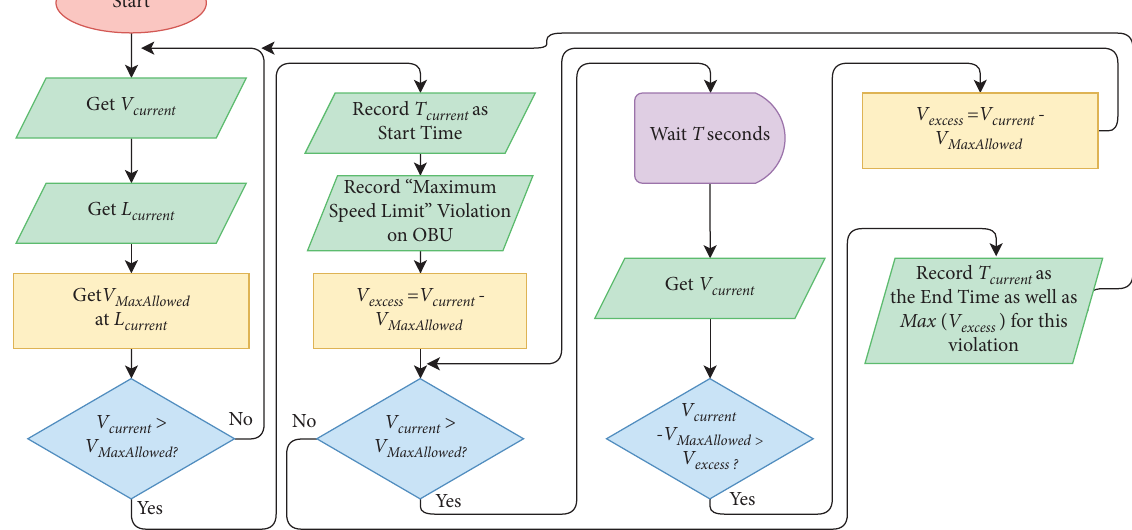
Figure 5: Flowchart of overspeeding violation detection using the OBU (simplifed fowchart of Algorithm